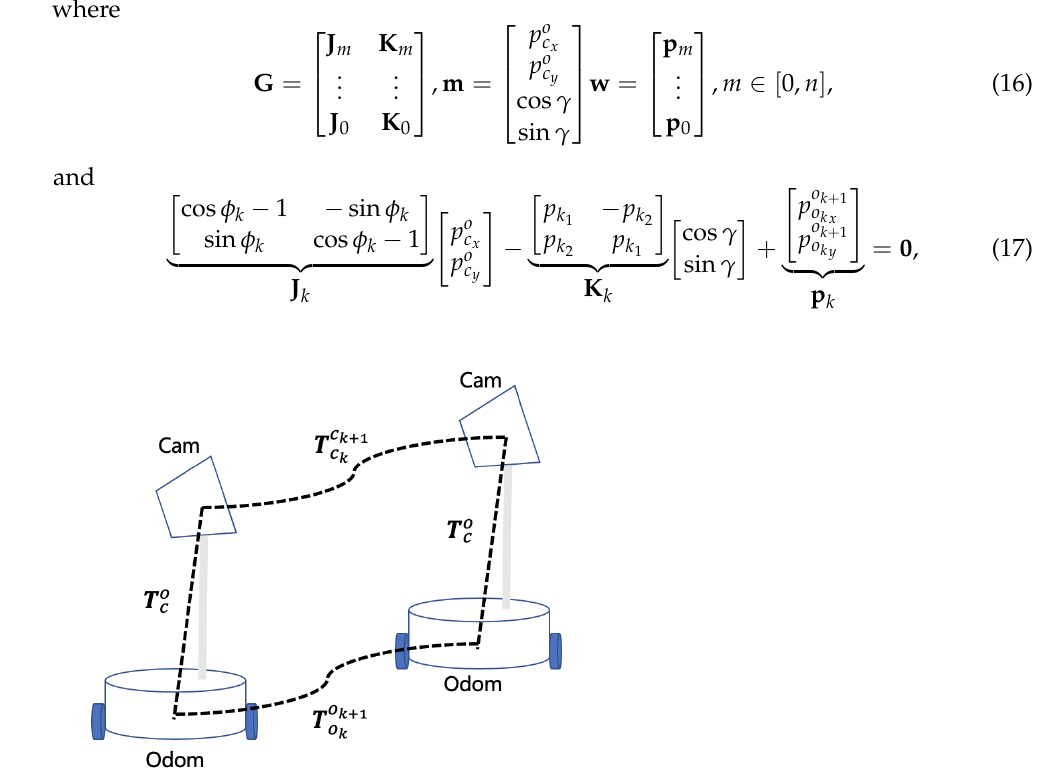
Figure 4. Pose conversion